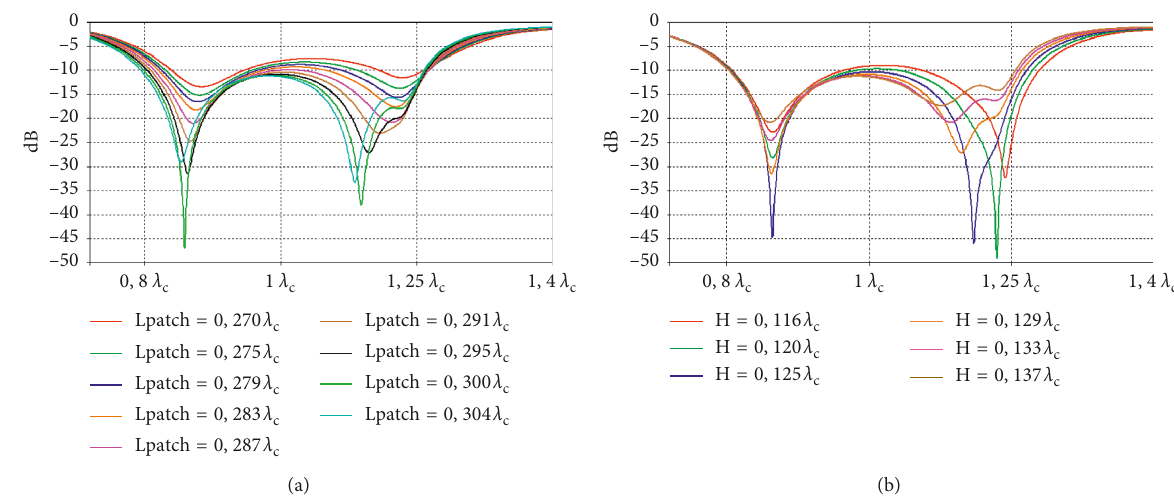
Figure 6: (a) S11 parameter evolution vs frequency (theoretical patch resonances when the patch is alone are positioned on the frequency axis when the patch is alone), (b) S11 parameter evolution vs frequency for the height of cavity using patch length (Lpatch) excitation � 0.295 λ c